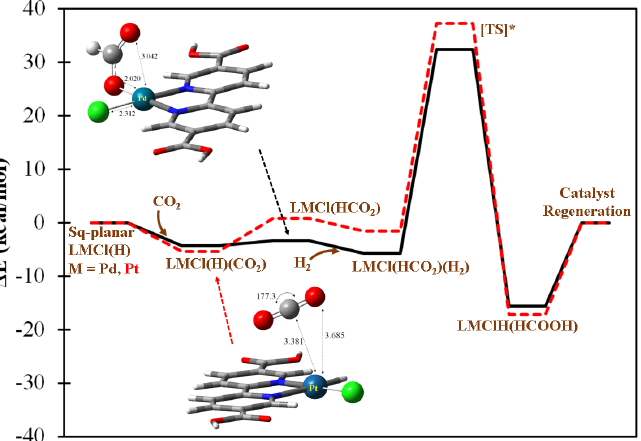
Figure 5. The predicted catalytic mechanism of formic acid generation by singlet (bpydc)MCl(H), M = Pd or Pt complex with H 2 (g) + CO 2 (g). The solid black and dashed red lines denote the catalytic pathways conducted by Pd and Pt complexes, respectively, and share the same text labels as the predicted intermediates. [TS*] denotes the approximate transition